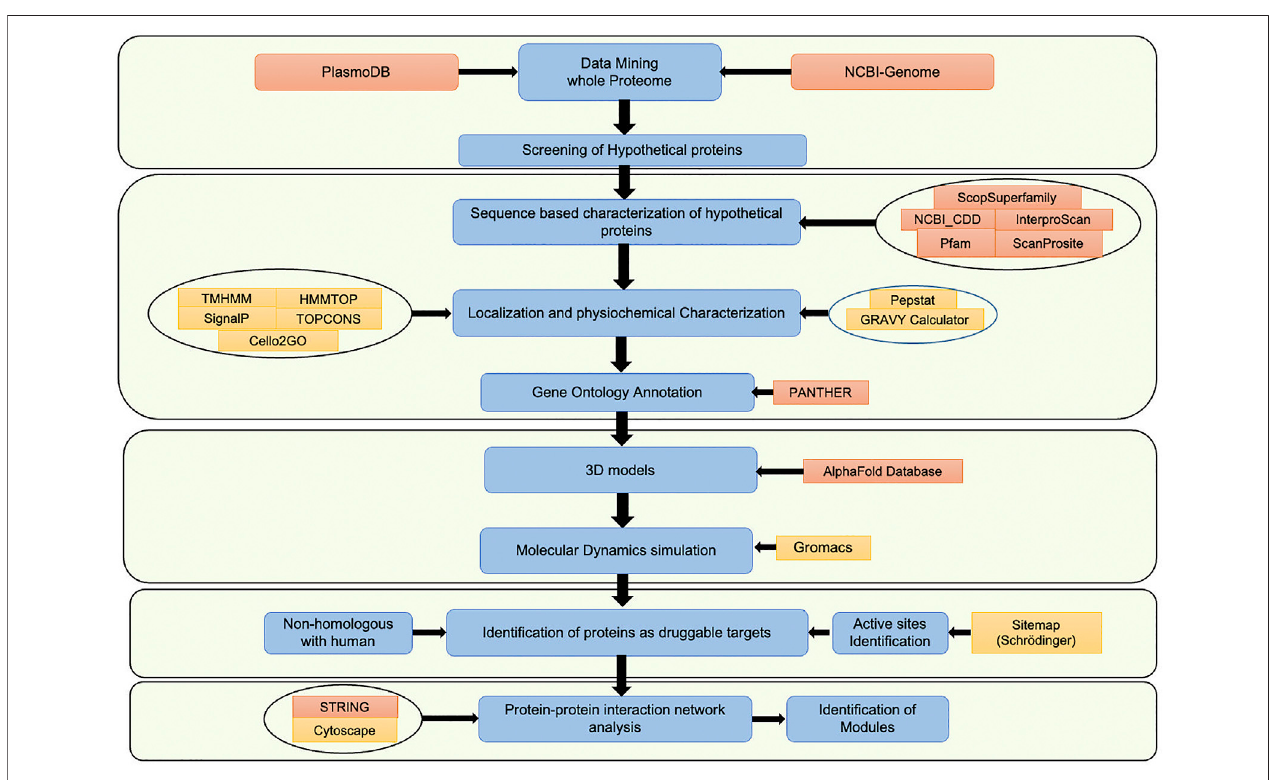
FIGURE 1 | Work fl ow representing the overall study